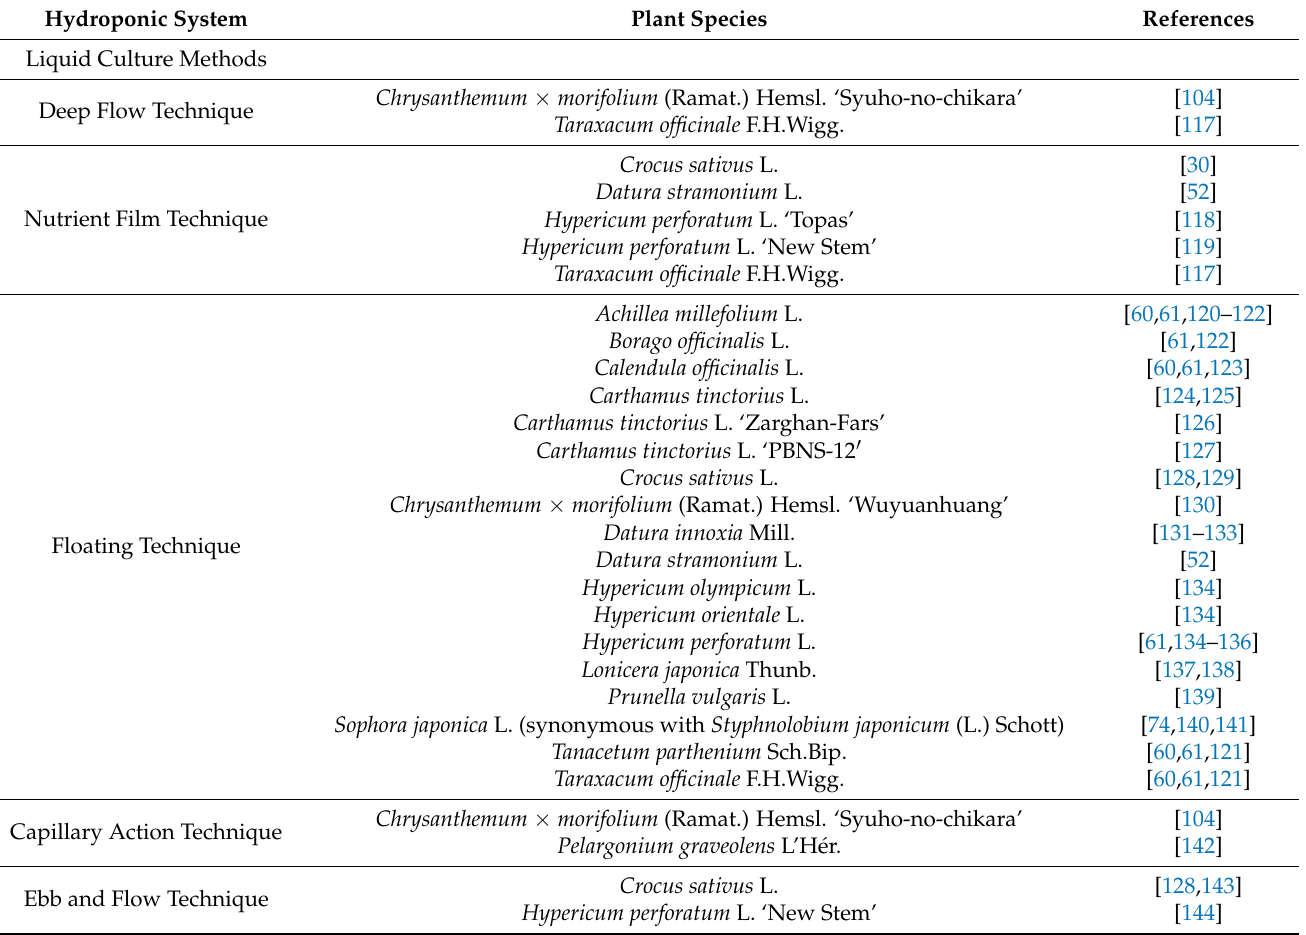
Table 2. Examples of publications discussing hydroponic cultivation of medicinal plants whose flowers are